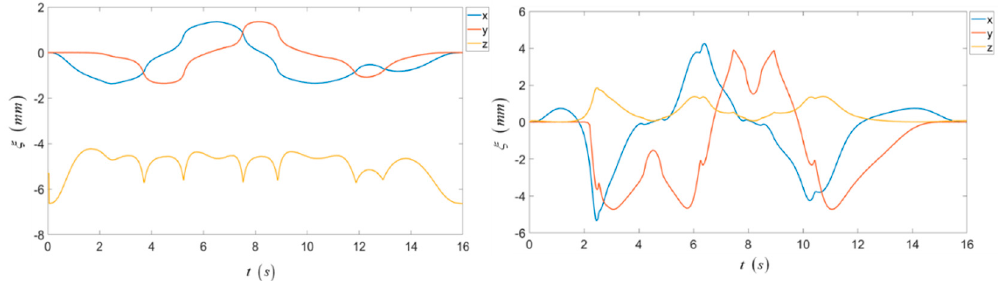
Figure 22. The positioning error of moving platform during the simulation test of both configuration (left: first configuration, right: second configuration).